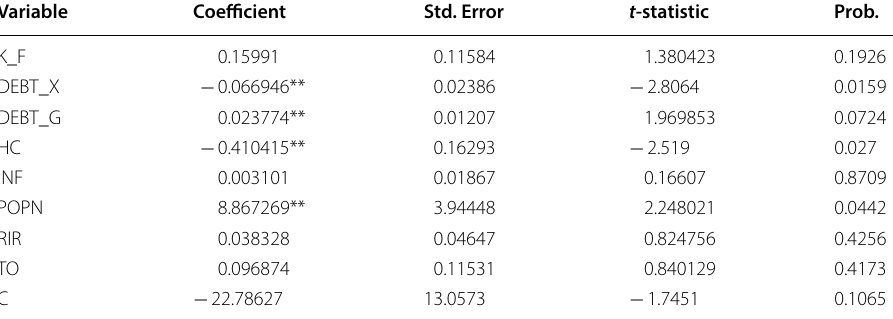
Table 9 Summary of the error correction model (long